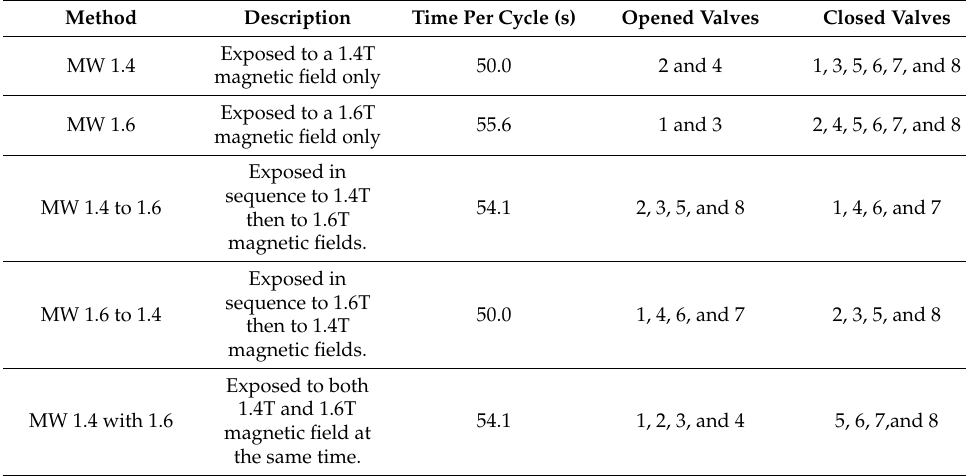
Table 2. Details of the water magnetization methods used (10 L water).